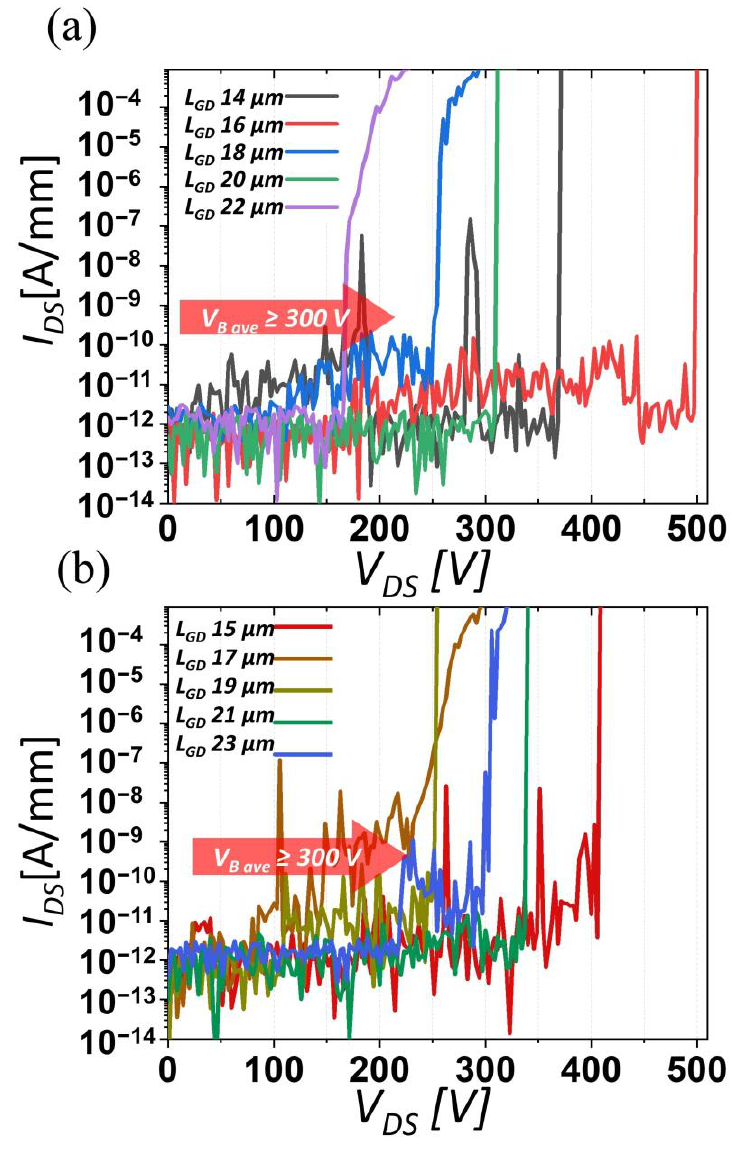
Figure 4. ( a ) Al 2 O 3 /AlGaN/GaN HEMT device average breakdown characteristics exceeding 300